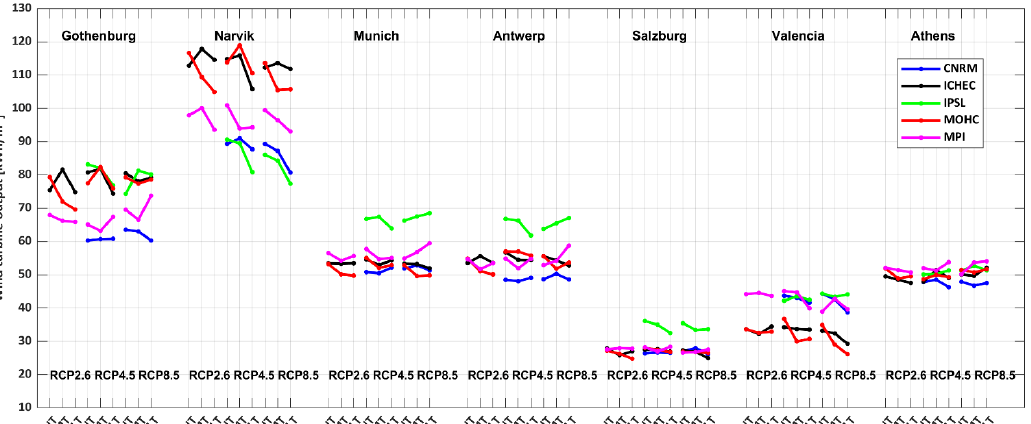
Figure 4. Average wind output in kWh/m 2 between NT, MT and LT at the hourly temporal scale for five GCMs: CNRM (blue), ICHEC (black) IPSL (green), MOHC (red), and MPI (pink).